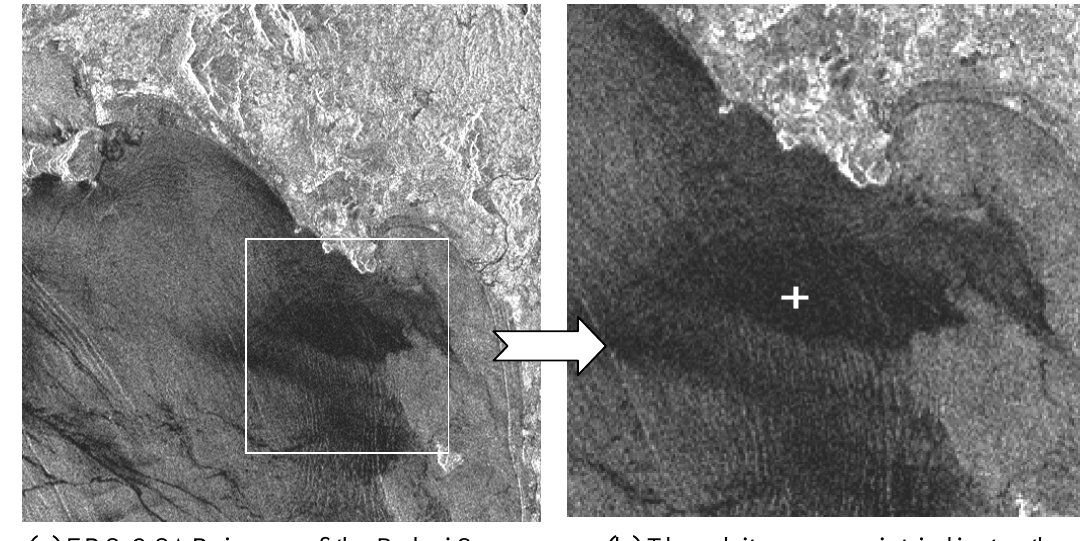
(b) The white cross point indicates the initialization of level sets for oil slicks